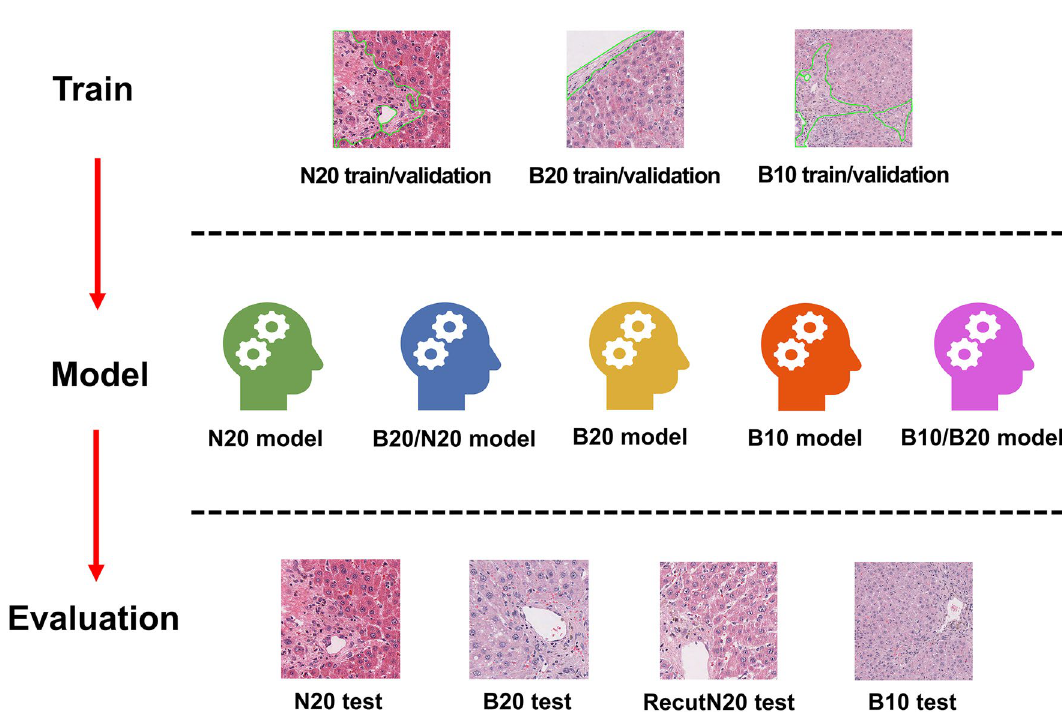
Figure 1. Scheme of the study